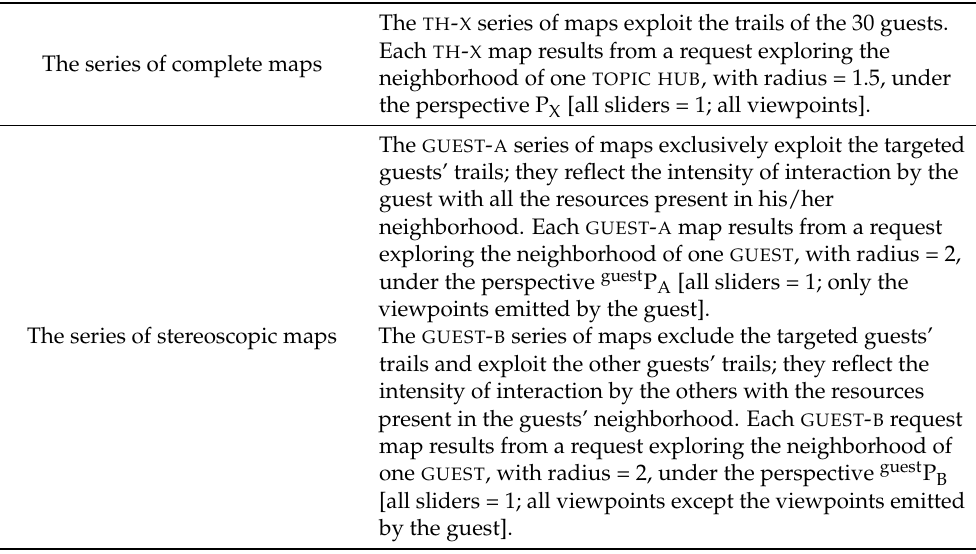
Table 2. The series of Garden-party knowledge